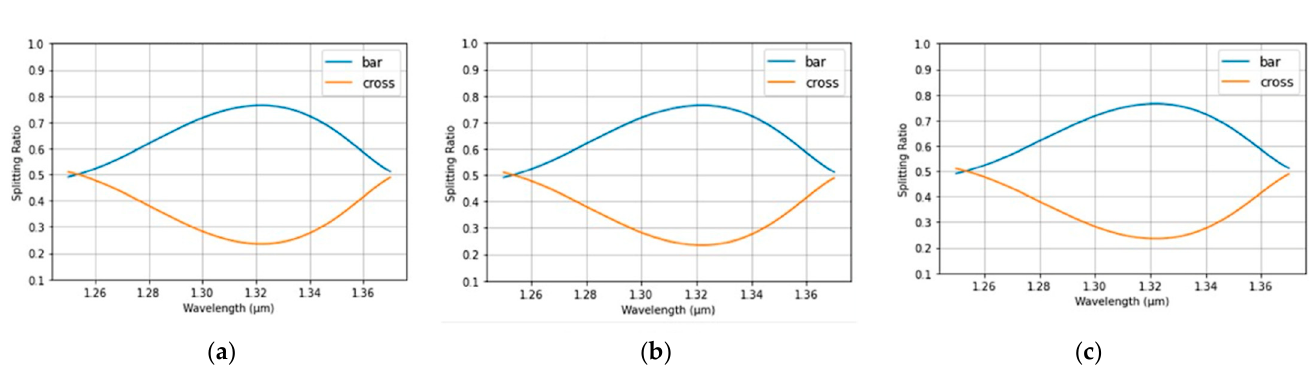
Figure 6. The simulated spectrum response for the unidirectional MZDC is demonstrated in the following situations: ( a ) without the waveguide width variation; ( b ) 10 nm width shift; ( c ) − 10 nm width shift.